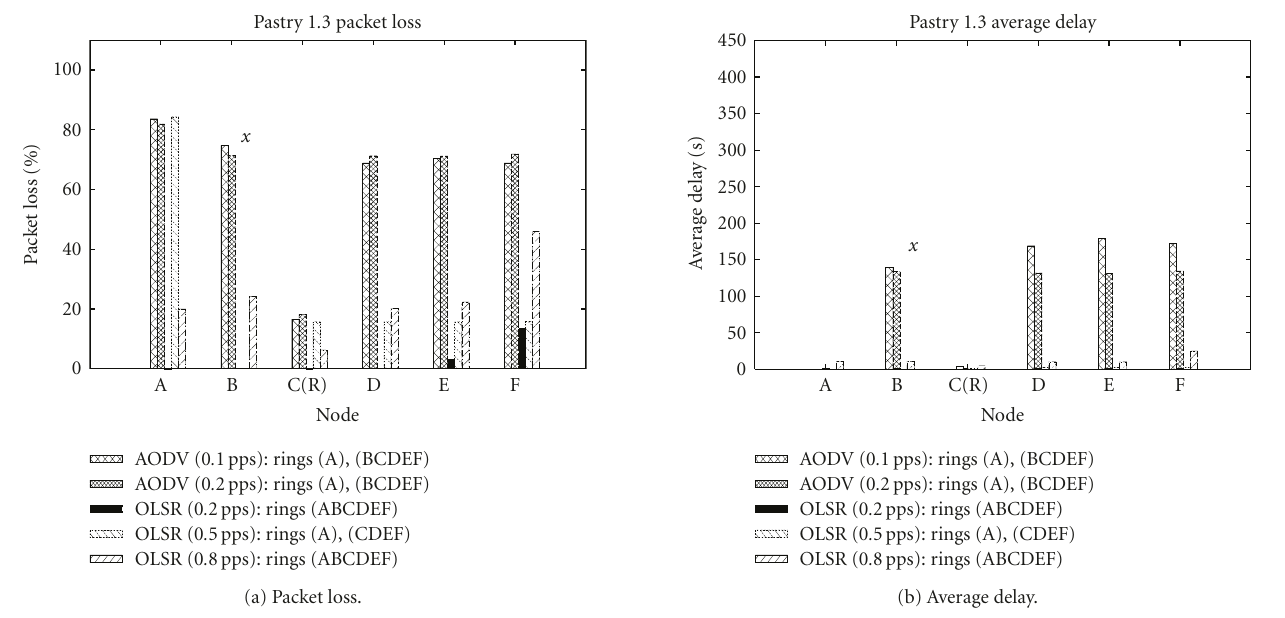
Figure 3: Pastry performance on AODV and